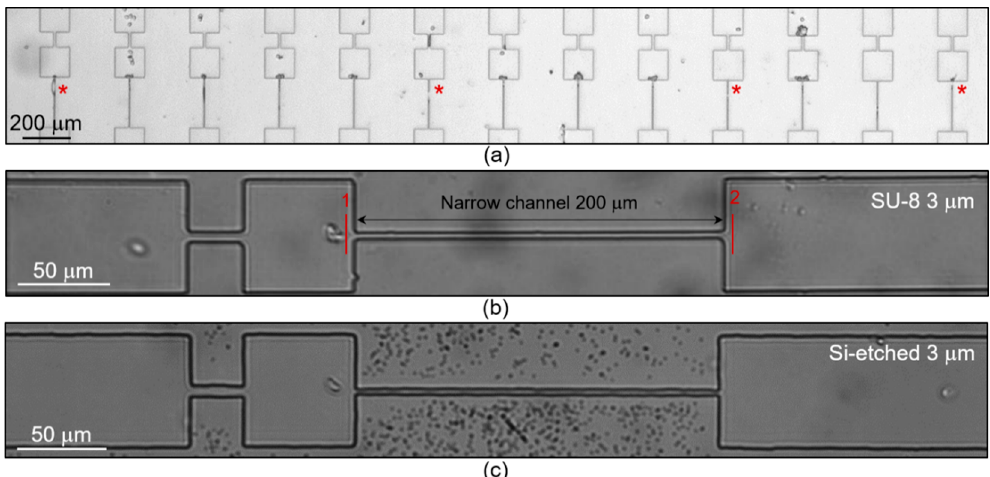
Figure 2. RBCs transport in microfluidic channels: ( a ) total view of occluded 1.5 µm wide channels by RBCs, treated with 0.5 mM of tBuOOH (* mark the damaged channels); ( b ) example of a 3 µm wide microchannel made by SU-8 mold (the marks indicate recognition points for the script to determine RBCs velocities); ( c ) example of a 3 µm wide microchannel made by Si-etched mold. All images were obtained by a brightfield optical microscope.